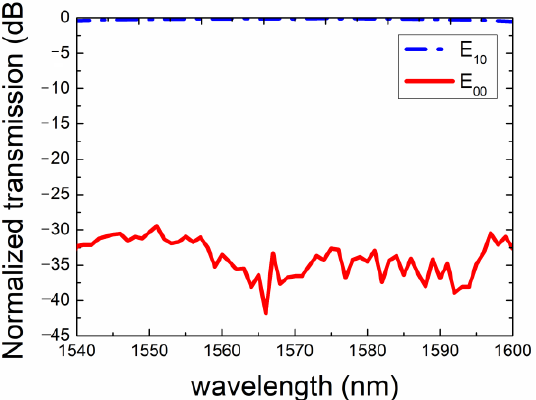
Figure 4. Normalized transmission of the proposed E 00 -E 10 mode converter when the wavelength varies from 1540 nm to 1600 nm.